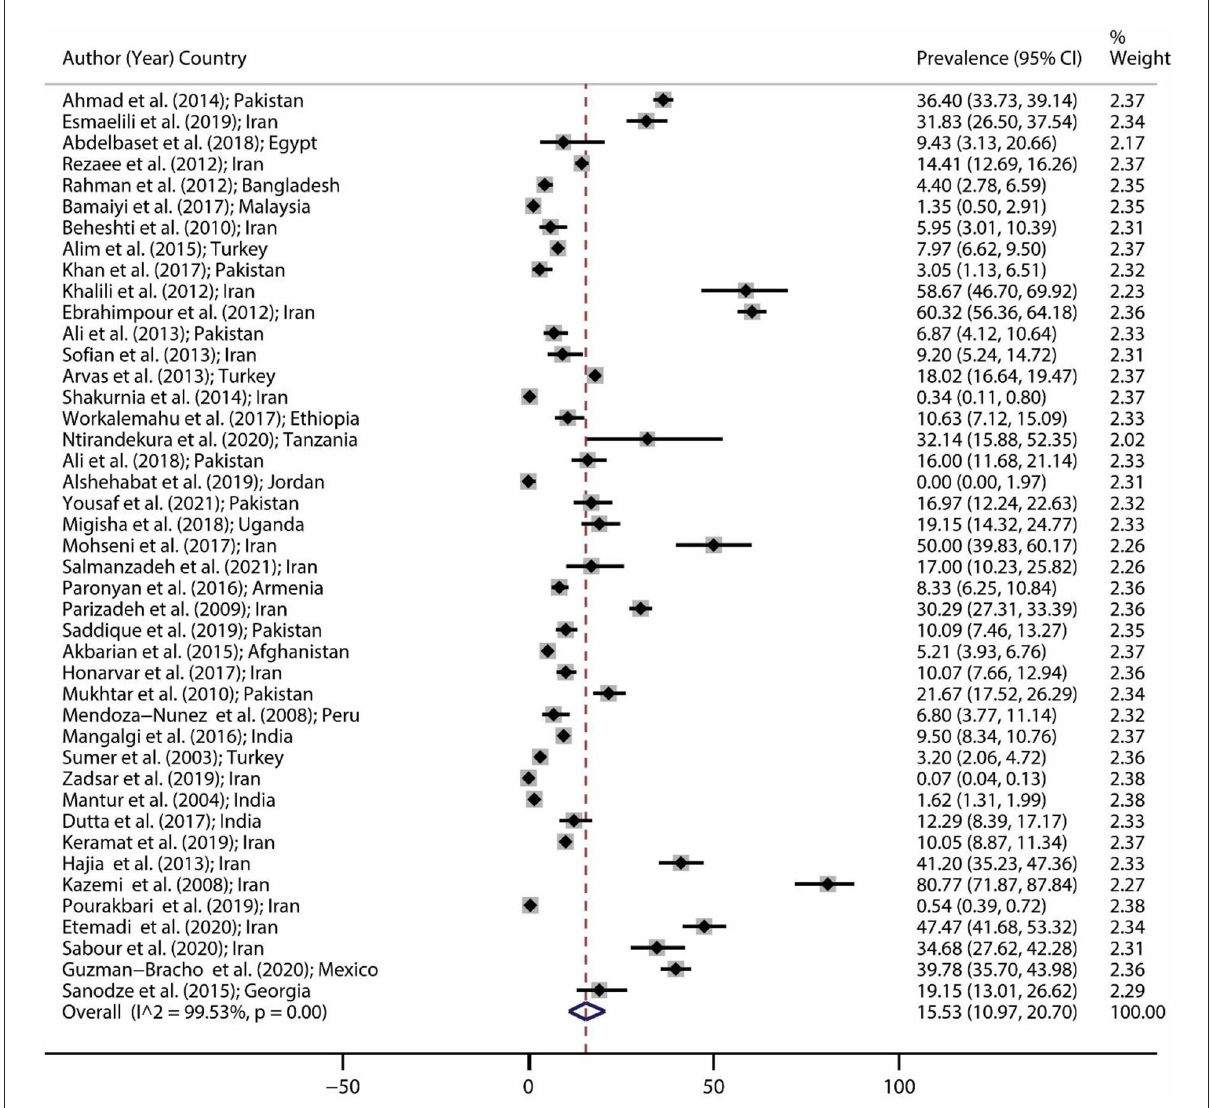
FIGURE2 Forest plot for brucellosis prevalence in the world based on a random-effect model. Each study identifies the first author (year) and country. Each line segment’s midpoint shows the prevalence estimate, the length of the line segment indicates a 95% confidence interval (CI) in each study, and the diamond mark illustrates the pooled